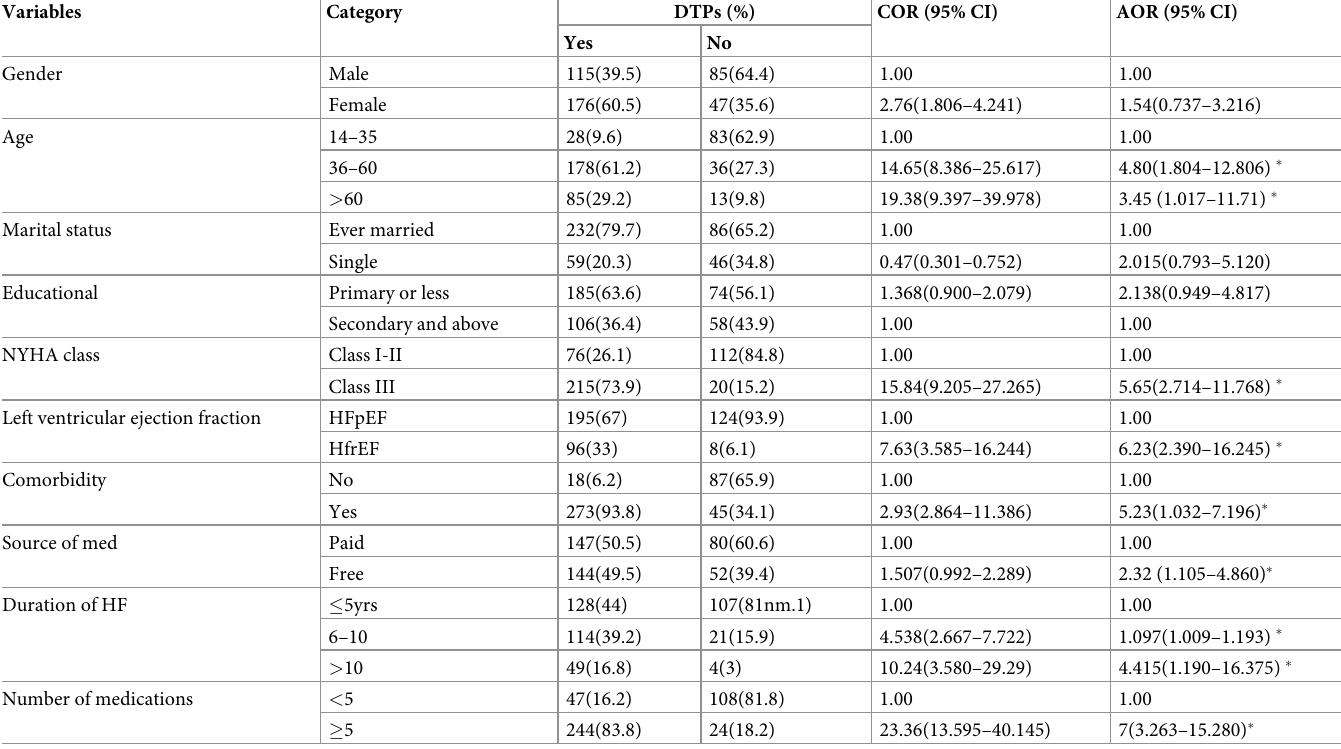
Table 7. Predictors of occurrence of drug therapy problems in heart failure patients attending the cardiac clinic of Tikur Anbessa Specialized Hospital, Addis Ababa, Ethiopia June—August, 2017.